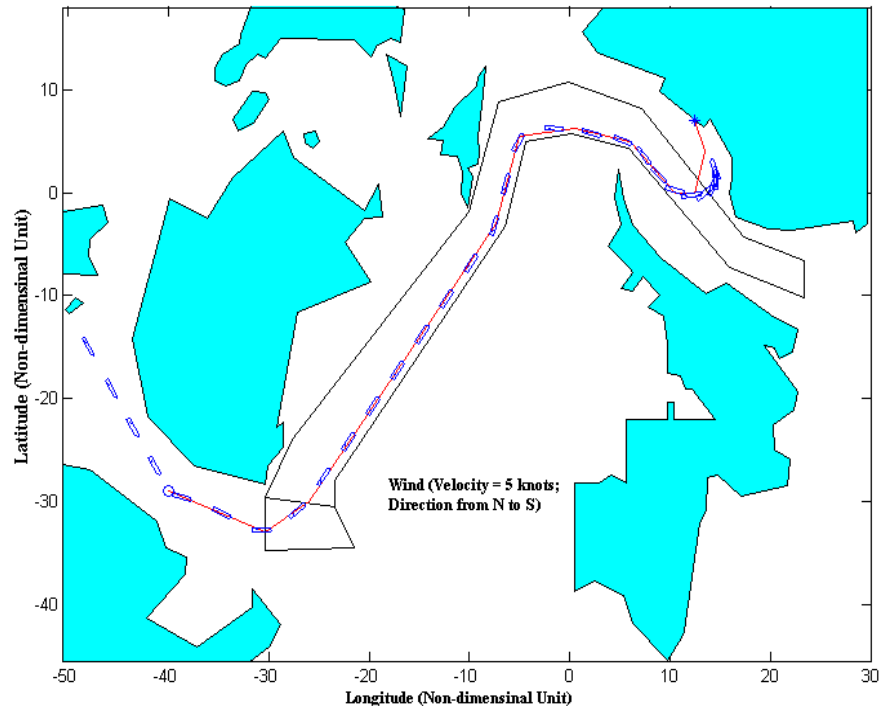
Figure 10. The track of ship controlled by an automatic navigation system under the wind disturbance (velocity 5 knots, direction from N to S).